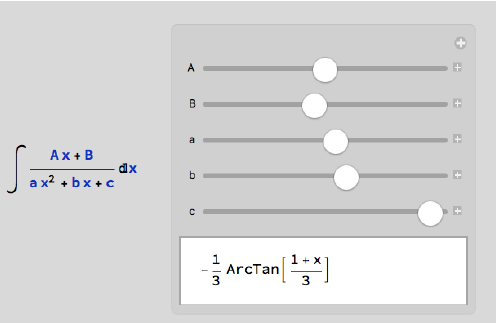
Figure 9. Example of an exercise proposed to encourage discussion, dialogue and reflection, available in the Computable Document Format: What kind of functions will appear if we change dynamically the parameter A